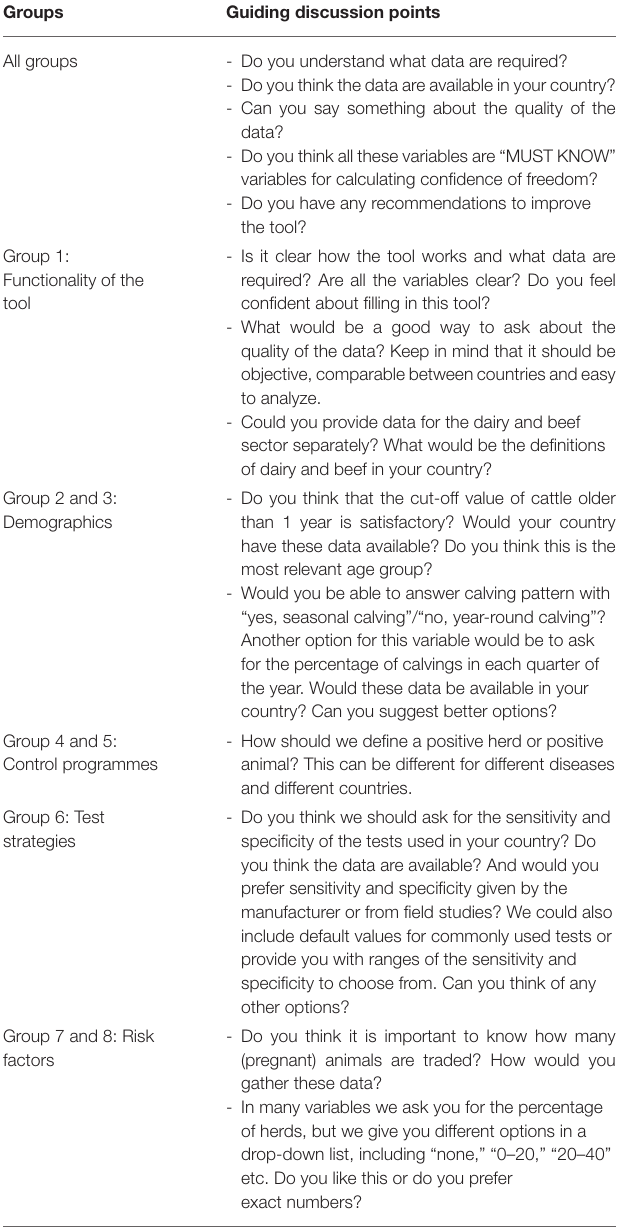
TABLE 2 | Groups within the SOUND control workshop that discussed specific aspects of the data collection tool.